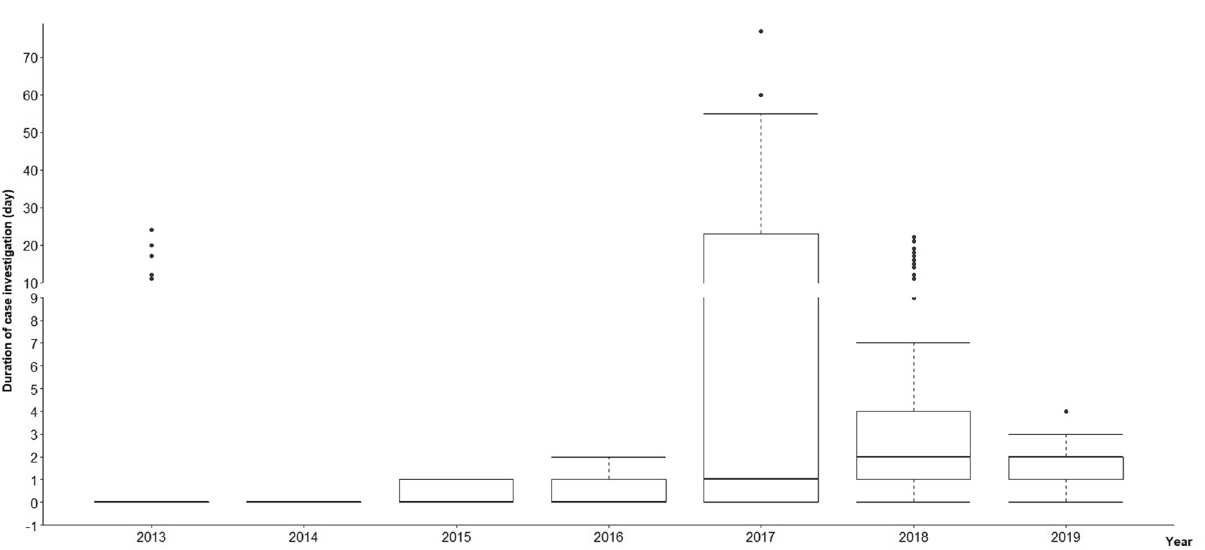
Figure 3. Durations of case investigations and confirmations by county CDCs, 2013–2019. The median, range and upper and lower quartiles, and discrete values of the data were divided by discrete duration ranges. The figure was created in R using ggplot2 package (R Core Team, Vienna, Austria, 2020, www.R- proje ct. org; version